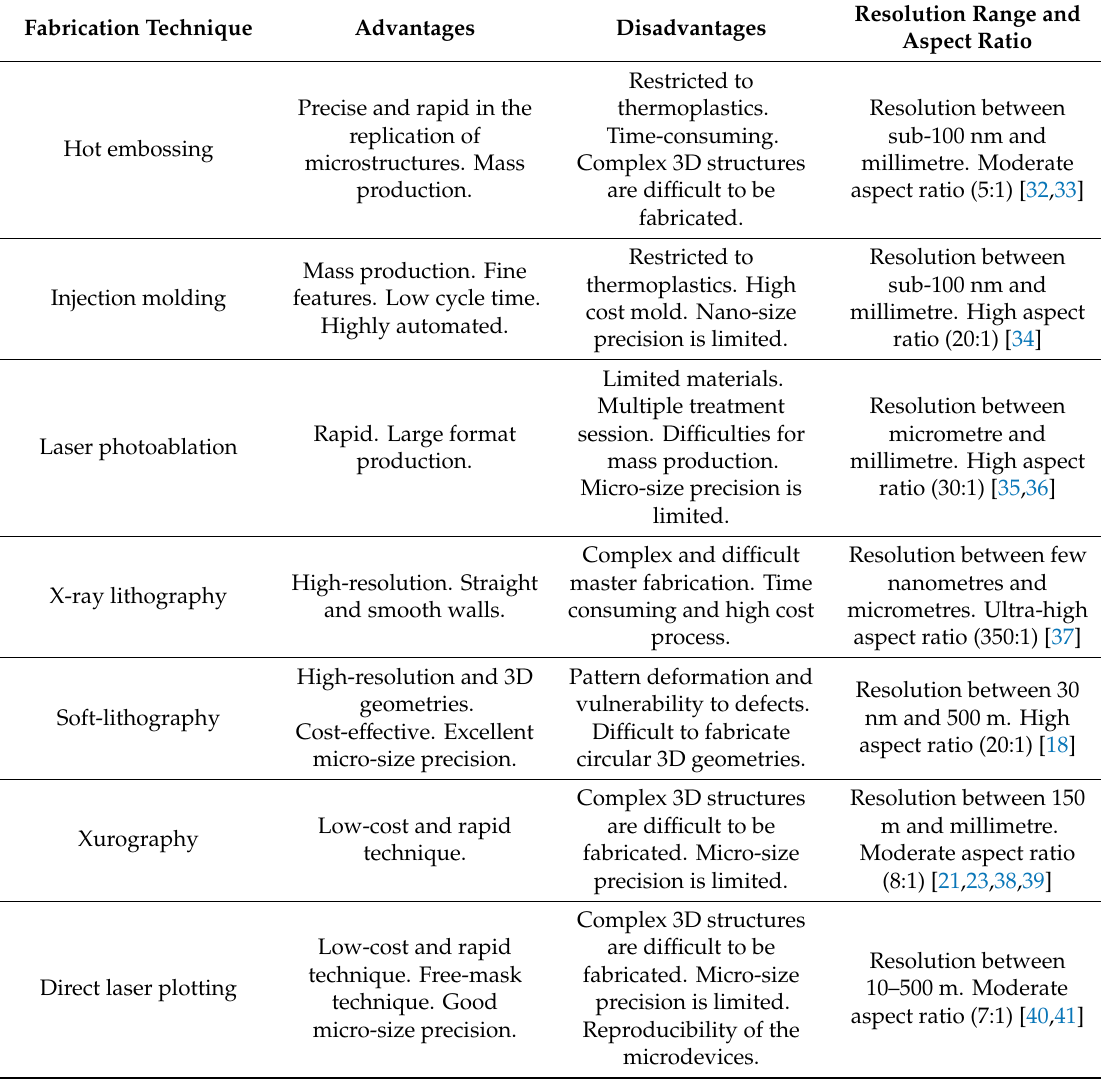
Table 1. Main advantages, disadvantages, resolution range and aspect ratio of microfabrication techniques used to develop microfluidic devices using polymer substrates. Adapted from [14]. Fabrication